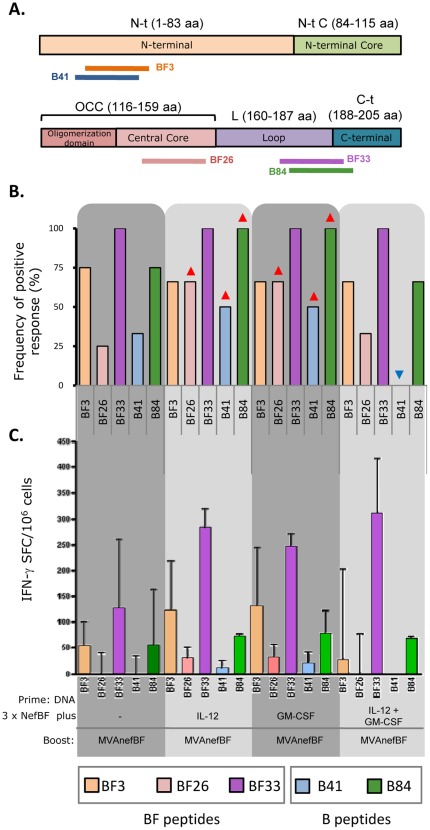
NefBF and NefB peptides targeted.
A) Nef Structural domains are represented and the localization of the targeted BF and B peptides is indicated. B) Recognition frequency represents the proportion of experiments in which a positive response was found for each indicated peptide. Red and blue arrows indicate differences (increments and reductions, respectively) compared to the control group. C) Bars show the magnitude median of the responses (number of IFN-γ secreting cells, evaluated by ELISPOT) detected in each group towards the different identified peptides. Data are from two to four independent experiments for the different groups and peptides.